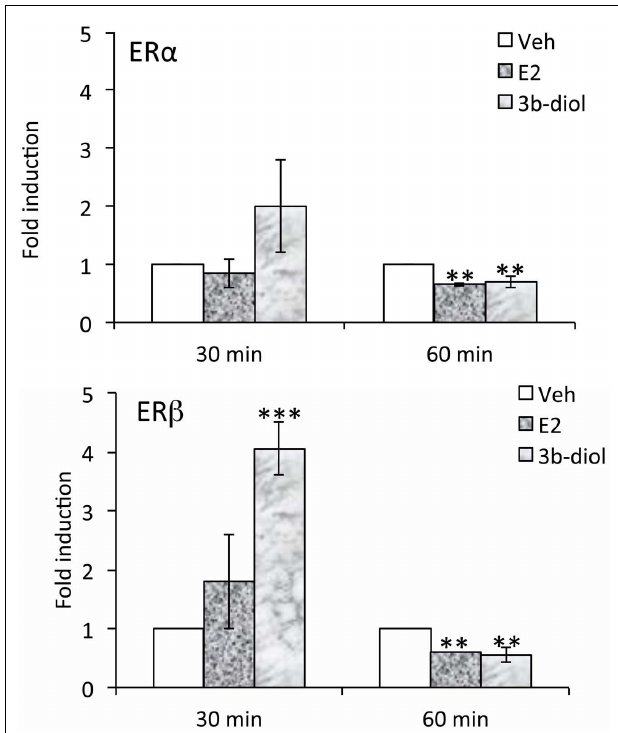
FIGURE 2 | E2 and 3 β -Diol lead to different patterns of promoter occupancy by ER α and ER β . mHypoE-38 cells were treated with E2 (10 − 7 M) or 3 β -Diol (10 − 7 M) for 30 or 60min. Anti-ER α or anti-ER β antiserum was used for chromatin immuno-precipitation followed by quantitative PCR of the OT promoter. n = 4; Bars represent the mean ± SEM and are presented as the fold difference of vehicle. **, p < 0.01, ***, p <